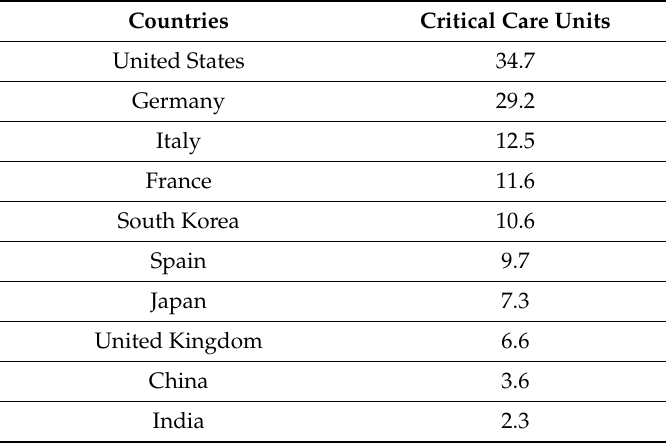
Table 10. Critical care units in di ff erent countries (per 100,000 inhabitants)